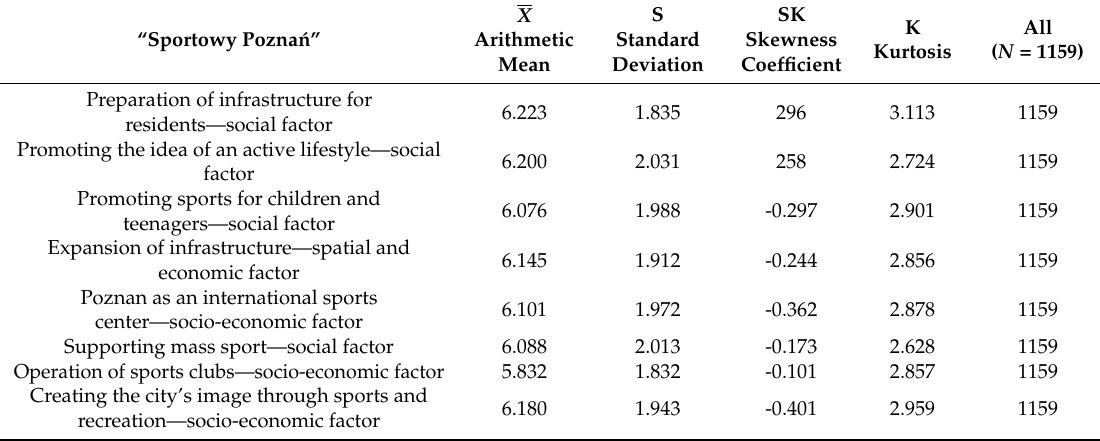
Table 5. Statistical characteristics of individual factors based on the opinions of service